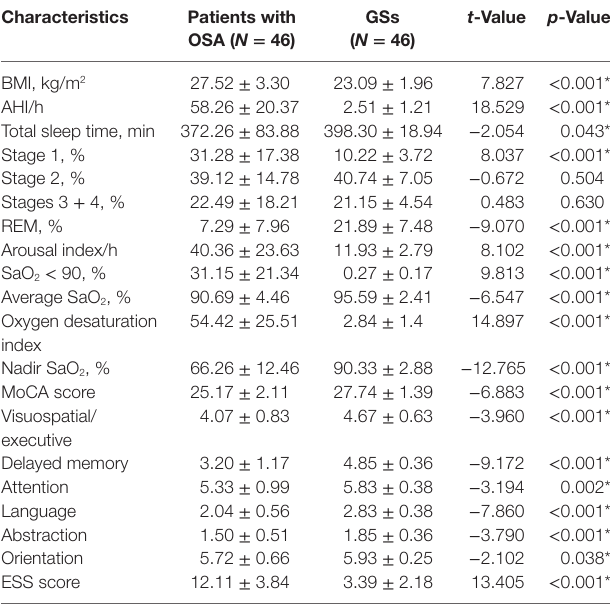
Table 2 | Comparison of the demographic and clinical data from the patients with OSA and